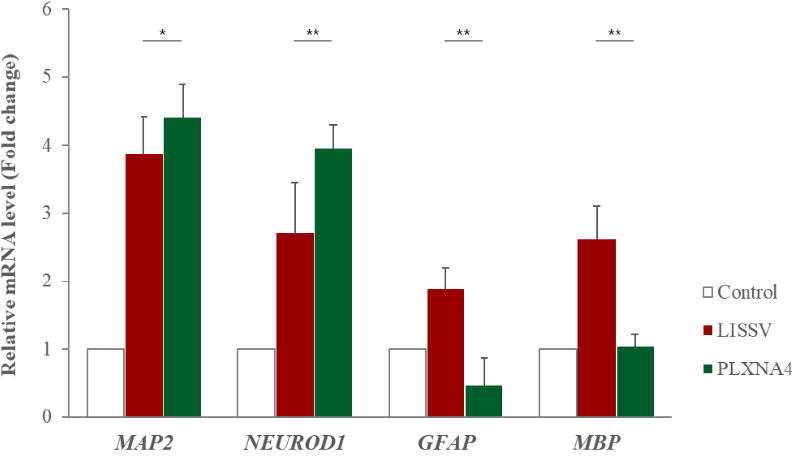
Figure 10. Expression of neural differentiation-specific genes in human umbilical-cord-derived